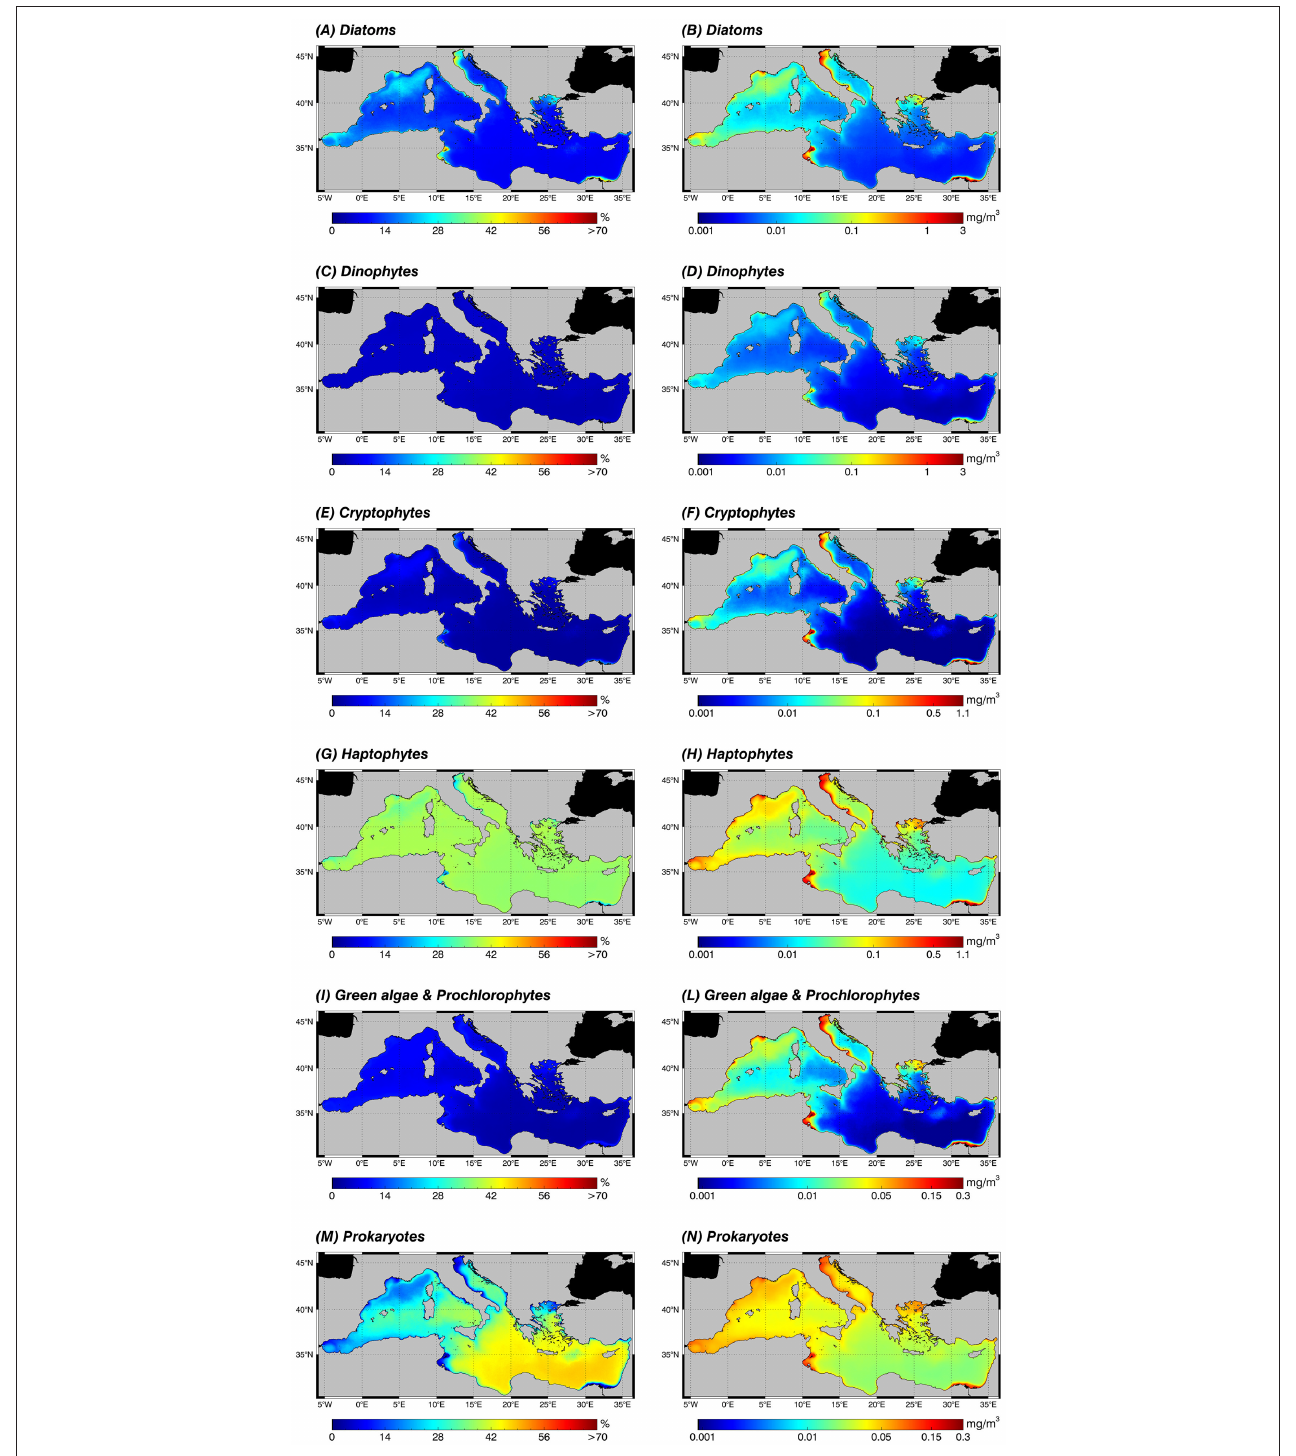
FIGURE 6 | Annual climatological maps (1998–2015) of the PFTs: for each pixel, fractions are expressed in % with respect to the TChl a (left panel: A,C,E,G,I,M) and the contribution of each PFT group to the TChl a concentration in mg m − 3 (right panel: B,D,F,H,L,N ). PFTs are retrieved applying the new regional algorithms (see Table 4 ) on the daily TChl a time series (Mediterranean reprocessed product produced by the CMEMS-OCTAC). Since the wide range of TChl a variability related to each PFT, note that the color scales could be different. (A,B) Diatoms, (C,D) Dinophytes, (E,F) Cryptophytes, (G,H) Haptophytes, (I,L) Green algae & Prochlorophytes, (M,N)